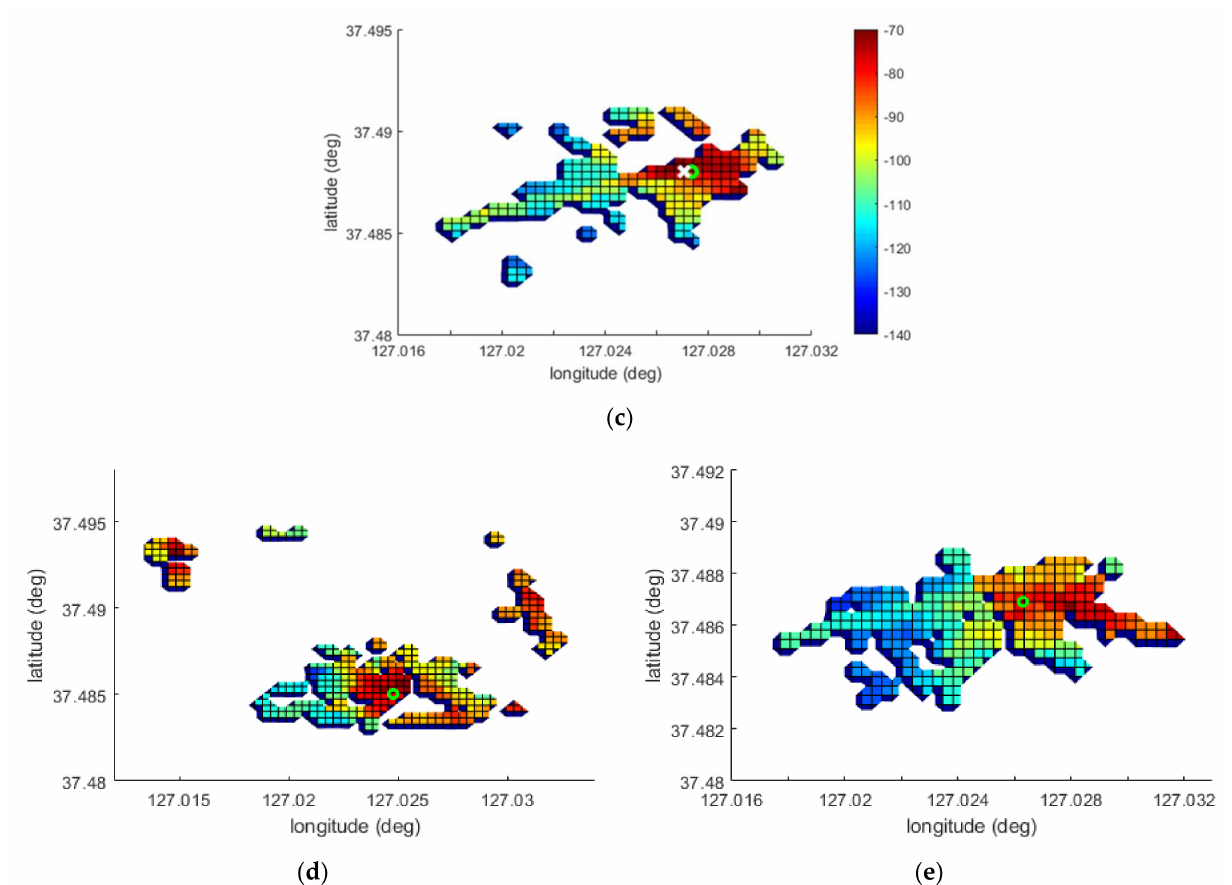
Figure 7. Results of SMaP and the comparison technique. ( a ) Result of positioning for the PCI–144 base station; ( b ) result of SPMing; ( c ) generated fingerprint database; ( d ) fingerprint database